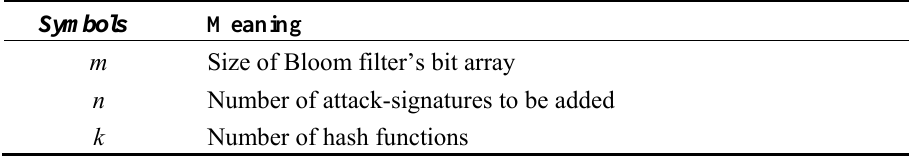
Table 2 lists the symbols used in the Evaluation section and their meanings: Table 2. Symbols and Their